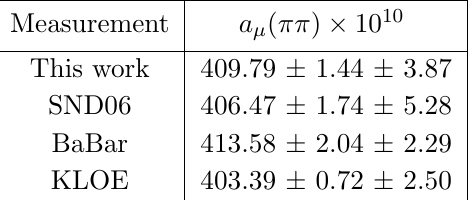
Table 4 . The contribution to the anomalous magnetic moment of the muon a (cid:22) ( (cid:25)(cid:25); 525MeV (cid:20) p s (cid:20) 883MeV) (cid:2) 10 10 derived from the SND and [26, 32, 50] data. The covariance matrix is used to calculate the statistical uncertainty for [32,